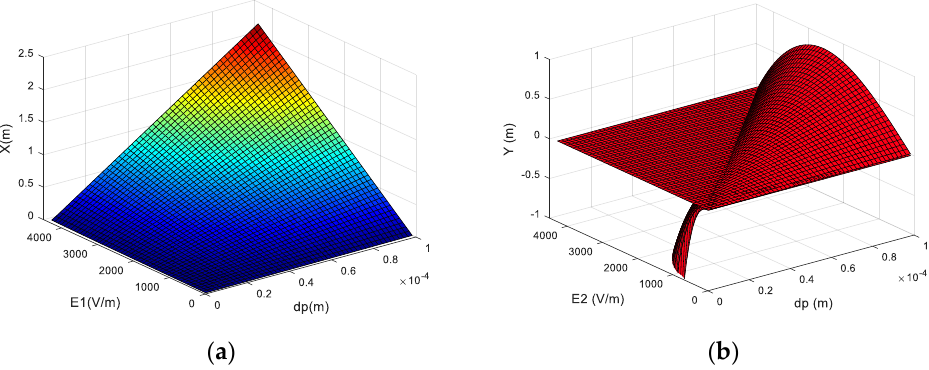
Figure 6. Dynamic displacement response of different electric field strengths and different particle diameters: ( a ) X -axis displacement response; and ( b ) Y -axis displacement response.